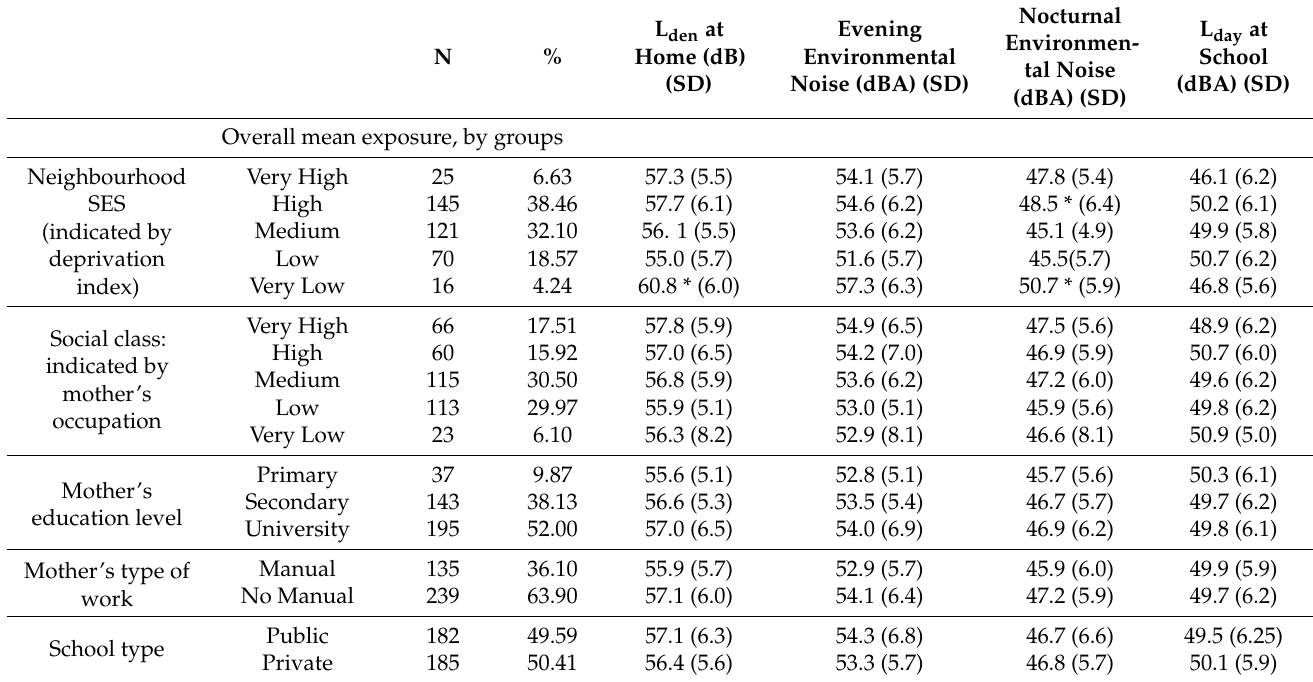
Table 2. Exposure means for each socioeconomic group. The results presented in the table are based on the total sample. For each group, sample size (N), frequencies and environmental noise means are given.